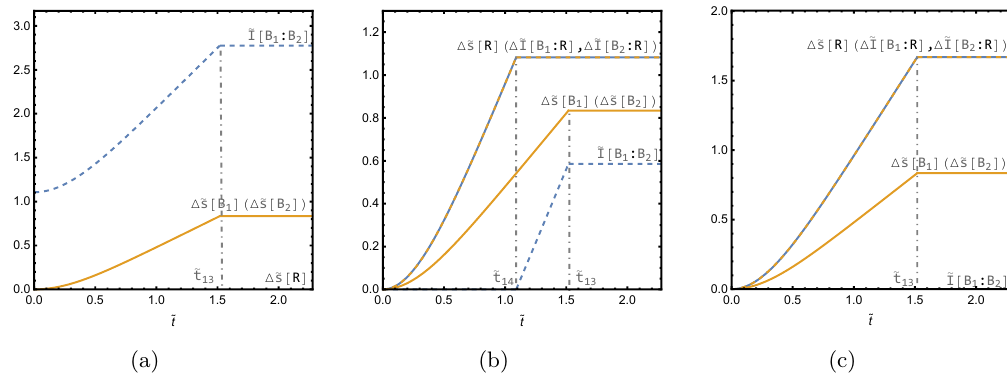
Figure 8 . The evolution on entropy and mutual information density at different distances (a): ˜ w 0 = 2 . 67 , (b): ˜ w = 3 . 91 , (c): ˜ w = 6 . 67 , while other parameters are specified to { L, θ 0 0 ˜ ˜ ˜ { 1 , π/ 2 , π/ 2 , 0 . 3 , 0 . 3 , 0 , 6 / 8 π } . Note that ∆ Q := Q ( t ) − Q (0) , where Q = s, I